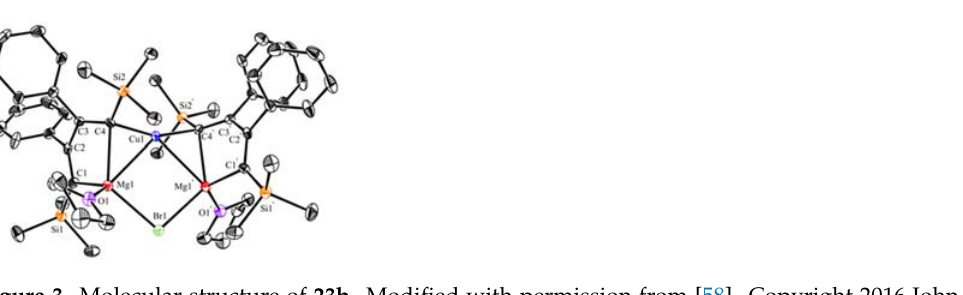
Figure 3. Molecular structure of 23b . Modified with permission from [58]. Copyright 2016 John Wiley and Sons.